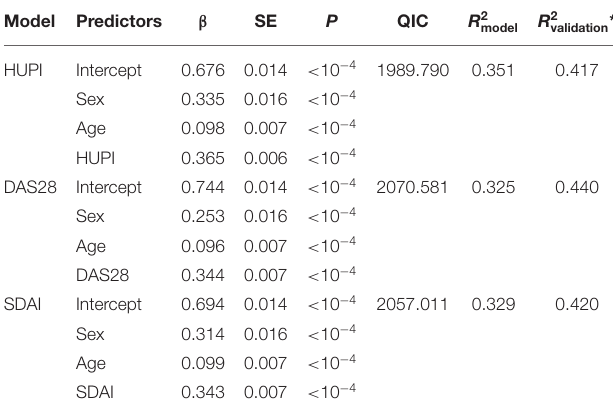
TABLE 1 | Models for HAQ comparing the performance of different